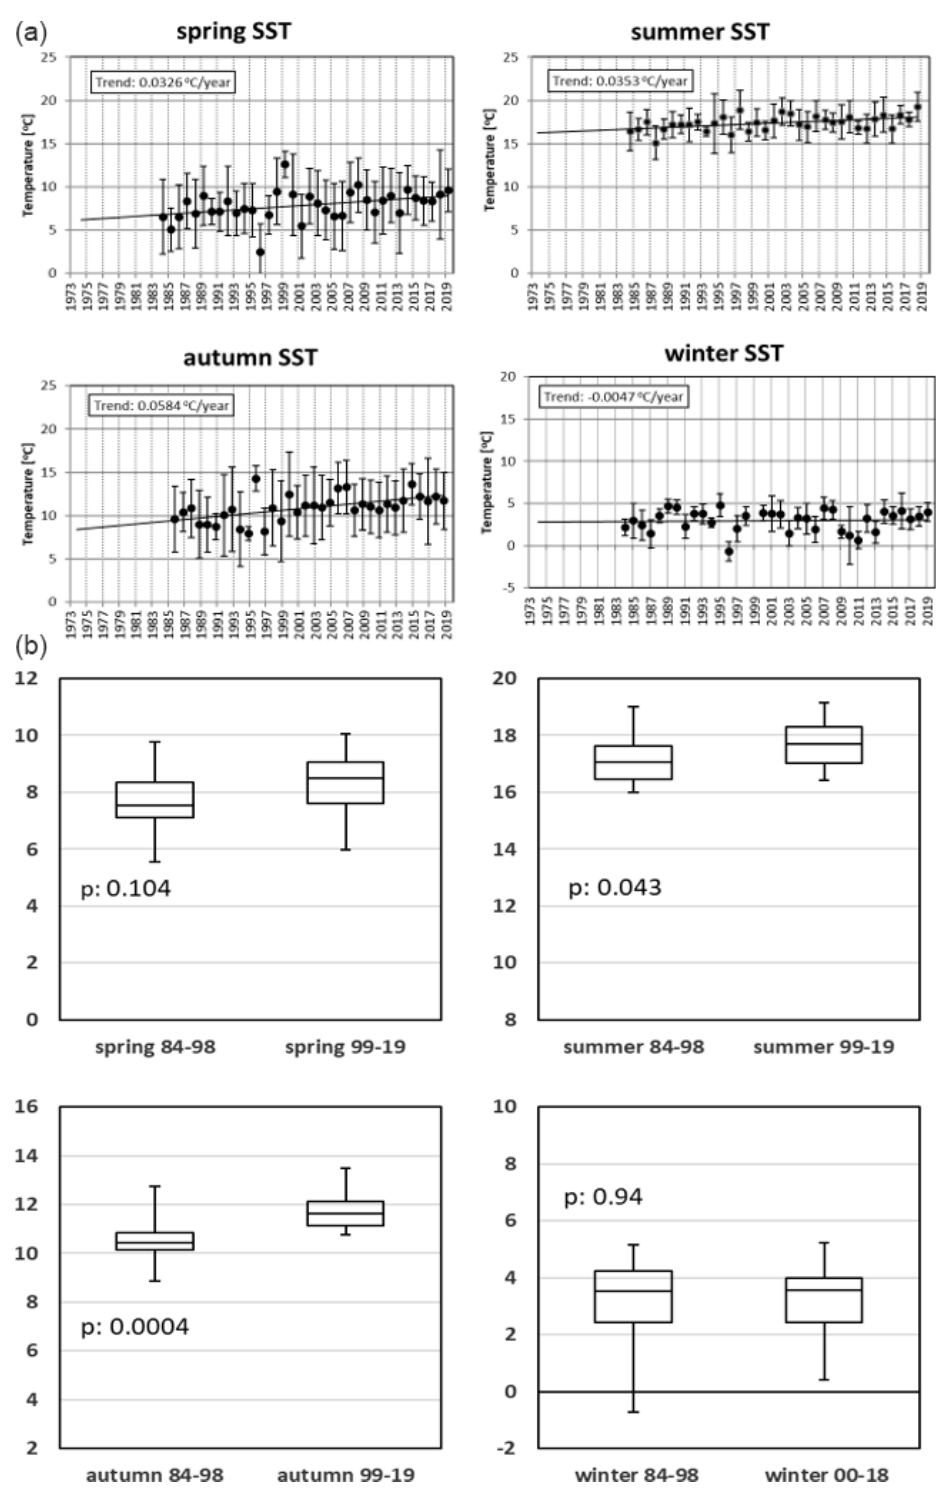
Figure 12. Development of SST over the course of the Sylt Roads LTER time series. Seasonal averages are shown, with the standard error of the mean (SEM) given as error bars. Data on linear seasonal trends (1984–2019) are shown in boxes. Panel (b) compares seasonal SST values ( ◦ C) for the early and recent part of the time